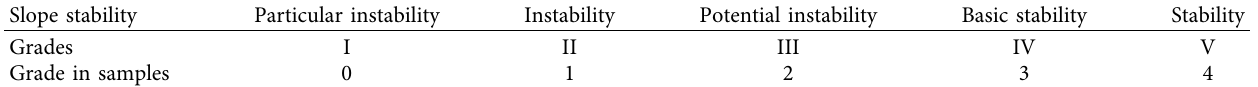
Table 2: Slope stability